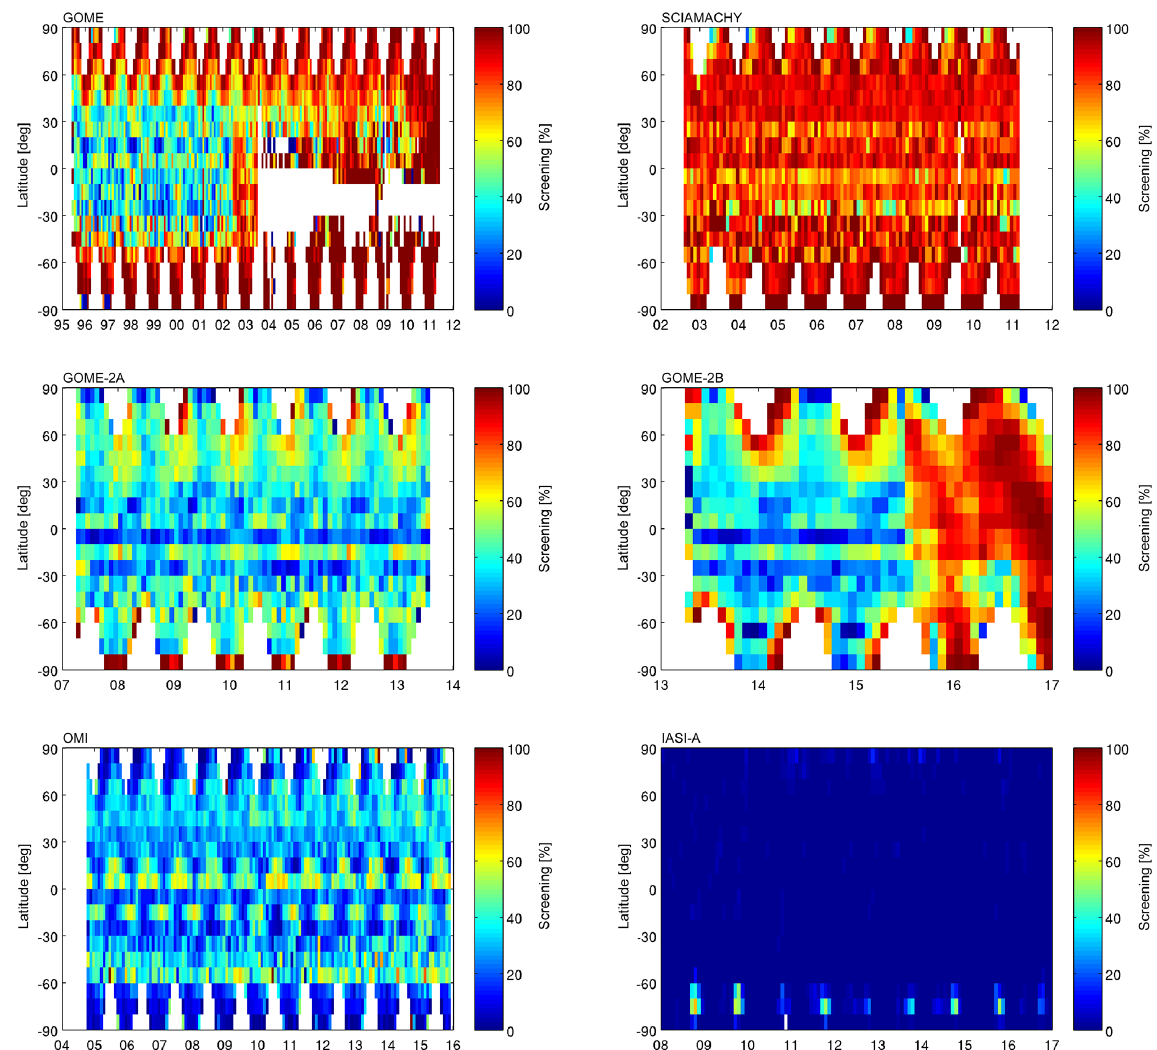
Figure 3. GOME, SCIAMACHY, GOME-2A, GOME-2B, OMI, and IASI-A (left to right and top to bottom panels) latitude–time distribution of relative data screening, taking into account the quality flags presented in Table 3. The decreased GOME-2B availability from June 2015 onwards points at a retrieval issue. IASI-B is fully similar to